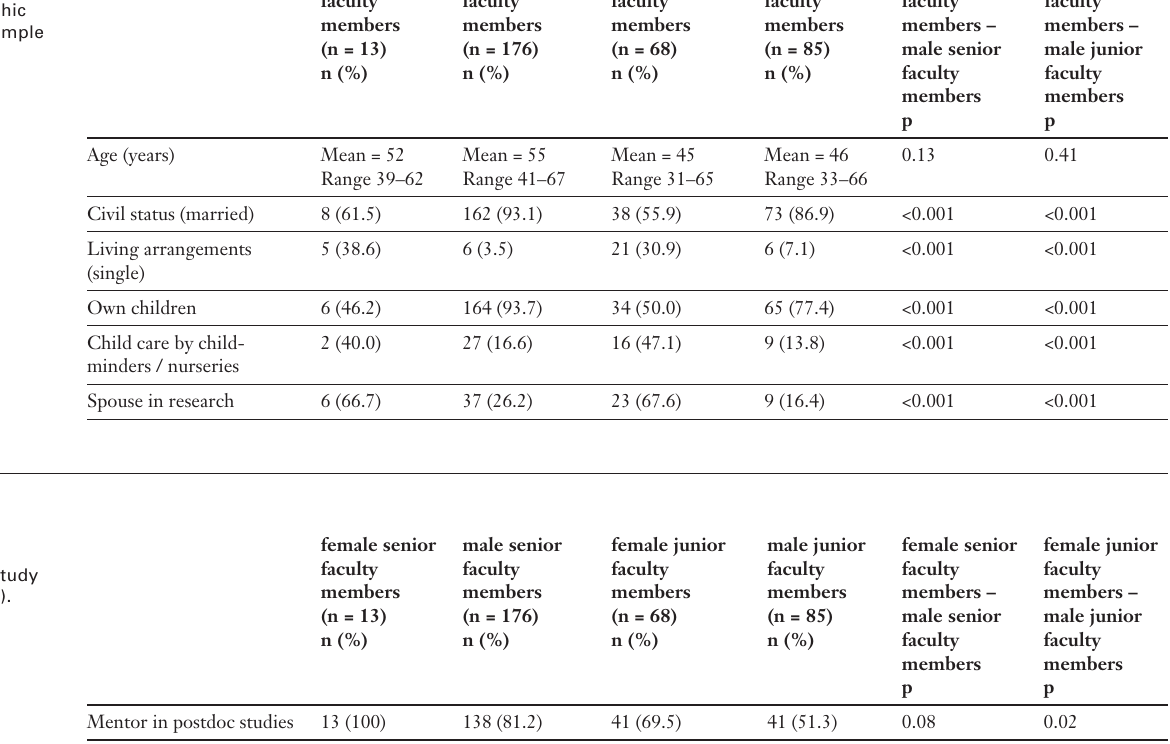
Sociodemographic data of study sample (n = 342).